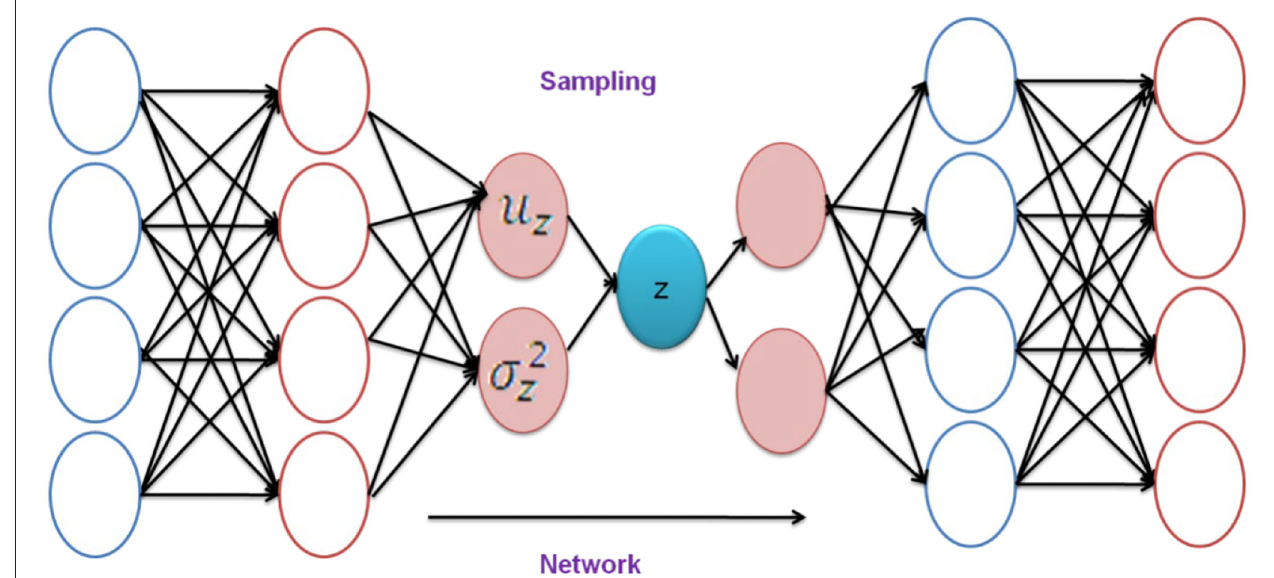
FIGURE 3 | Framework of VAE.